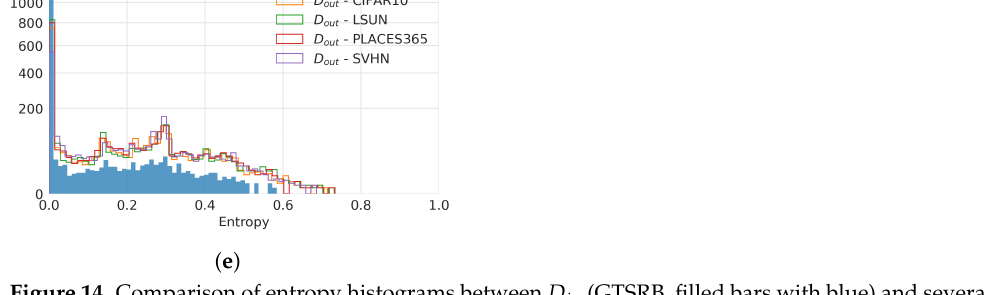
Figure 14. Comparison of entropy histograms between D in (GTSRB, filled bars with blue) and several D out (not filled bars and coloured according to dataset used) for different methods. We either used the triplet loss (TAE), the second variation of the PIRL (II-AE) or just the vanilla reconstruction loss (AE) and compare them against MC Dropout and an ensemble of models. MCA-II-AE provides the best separation between D in (in-distribution) and D out (out-of-distribution). Moreover, the different D out have a more similar distribution compared to the other models, which we also evaluate quantitatively. Notice the non-linear scale on the y-axis (number count per bin) to ease visualization for smaller values. ( a ) MC-AE. ( b ) MC-TAE. ( c ) MC-II-AE (Ours). ( d ) MC Dropout. ( e ) Ensemble. Table 6. Comparison of AUROC (in percentage, larger is better) of our method against MC dropout and an ensemble of models (Ensemble) as well as vanilla (AE) and triplet autoencoders (TAE) either using the second variation of the PIRL (II) or not. We repeated the experiments for 10 runs and report the mean and standard deviation. If D in = D out , then we report the result on the test set of D in . D in is in-distribution data and D out out-of-distribution data. Best results are highlighted in